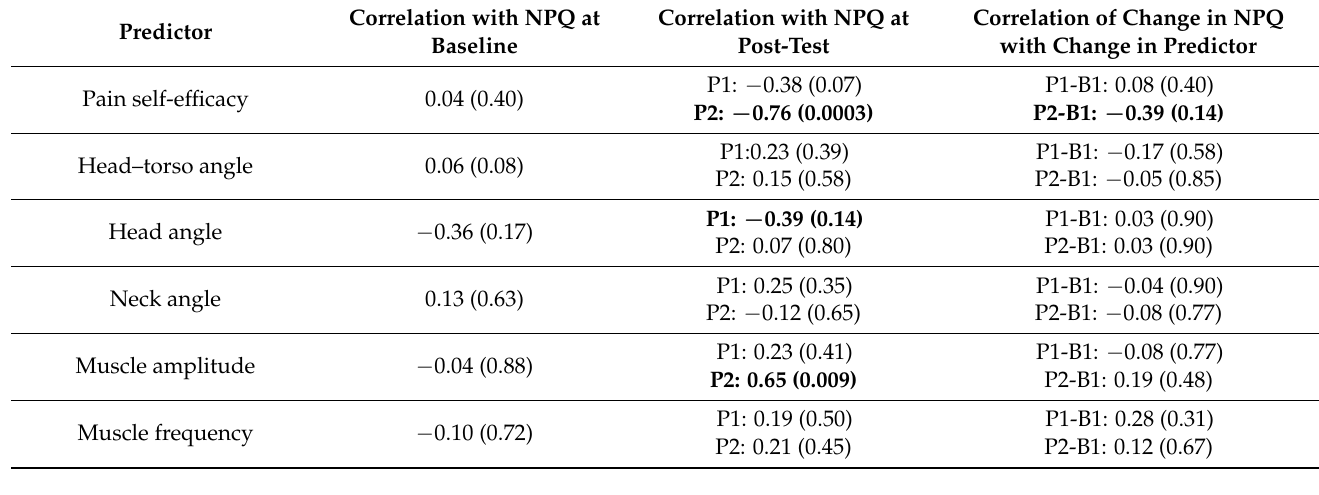
Table 4. Correlations between neck pain and possible predictor variables.